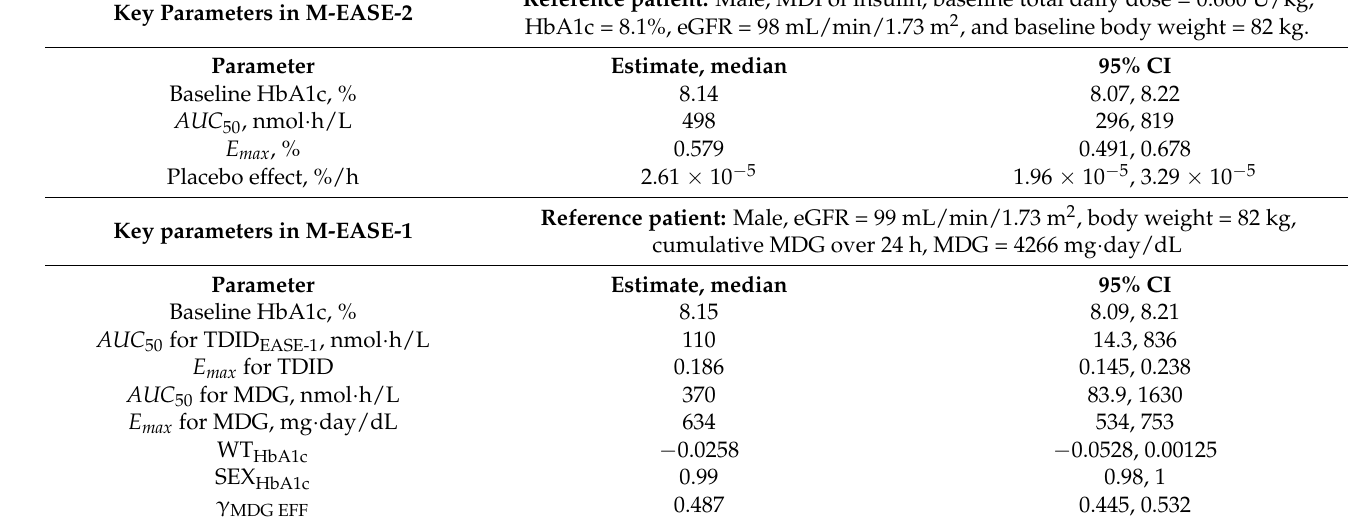
Table 3. Exposure–response parameters in M-EASE-1 and